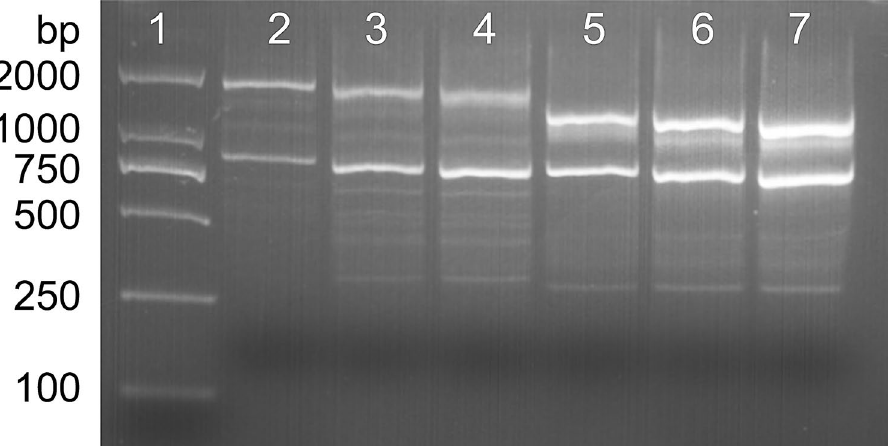
Figure 1. Specific fragment of T. laevis with an inter-simple sequence repeats (ISSR857) primer. Lane 1: DL2000 DNA ladder, Lanes 2–4: T. laevis , Lanes 5–7: T. controversa